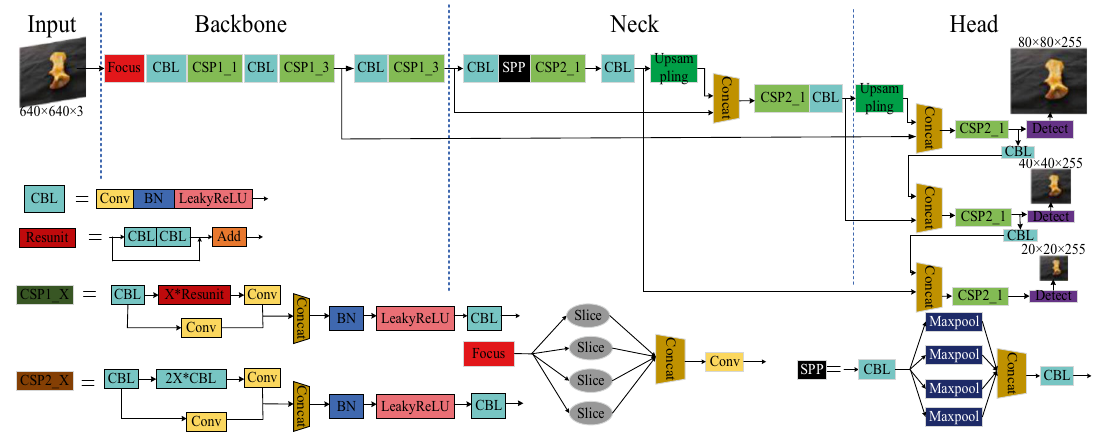
Figure 1. YOLOv5 algorithm network model structure.